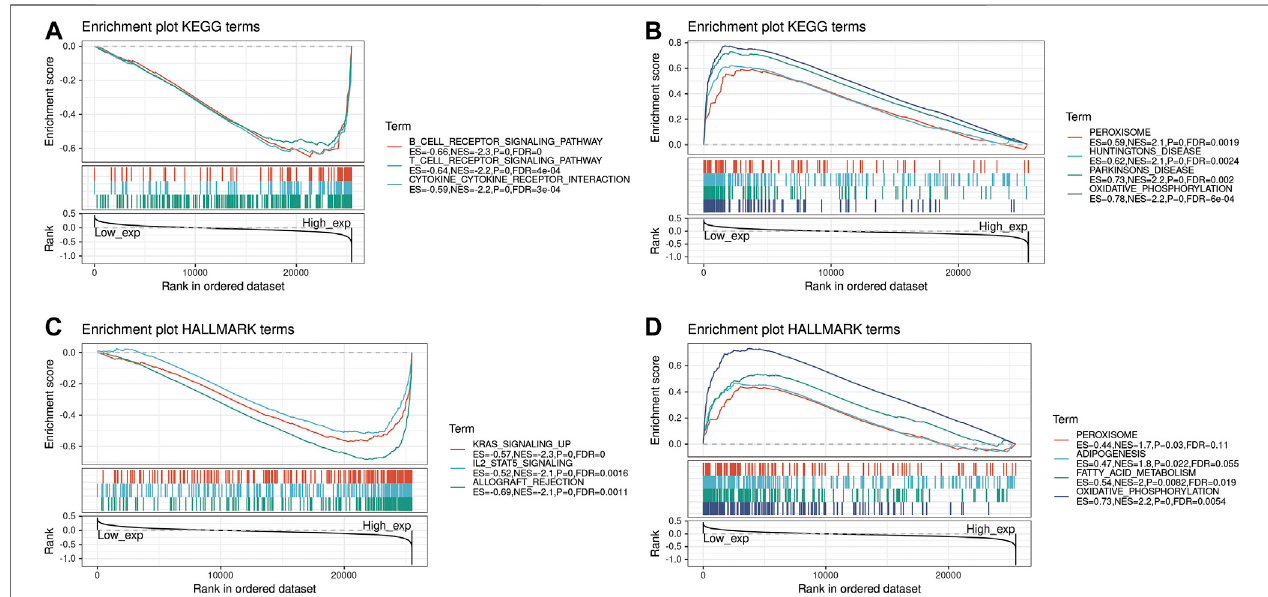
FIGURE 7 | Functional Enrichment of KEGG and HALLMARK terms on PRDM1 through GSEA. The top three negative and positive enriched KEGG terms were displayed in (A) and (B) respectively. The top three negative and positive enriched HALLMARK terms were displayed in (C) and (D) respectively.